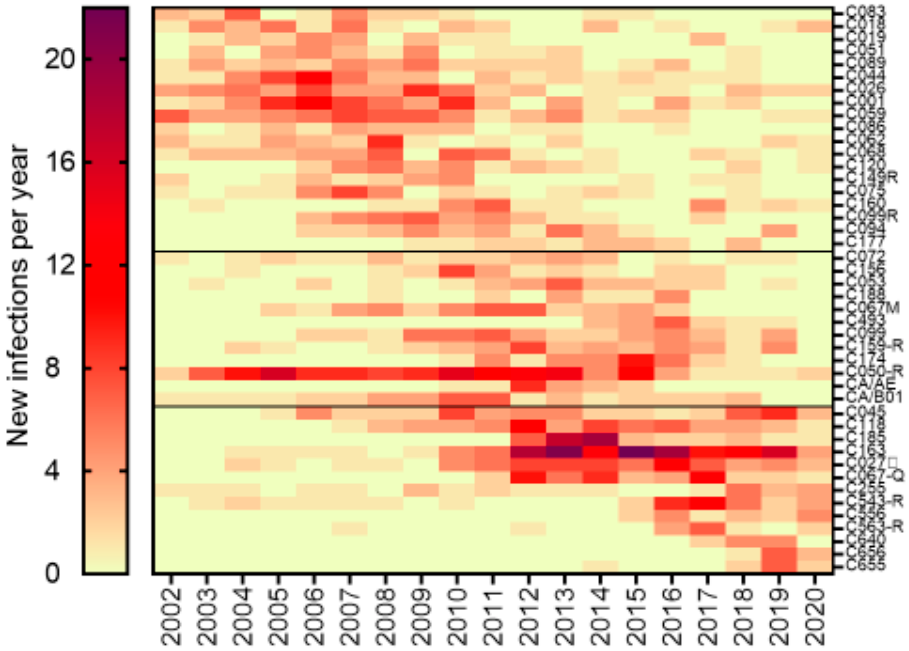
Figure 3. Growth trajectories of 44 large cluster MSM micro-epidemics having 20+ members. The heatmap colour gradient shows the number of infections added each year over the 2002–2020 period. Clusters were ordered chronologically to show waning, actively growing, and newly emergent clusters. The clusters harbouring drug resistance are indicated with an R.